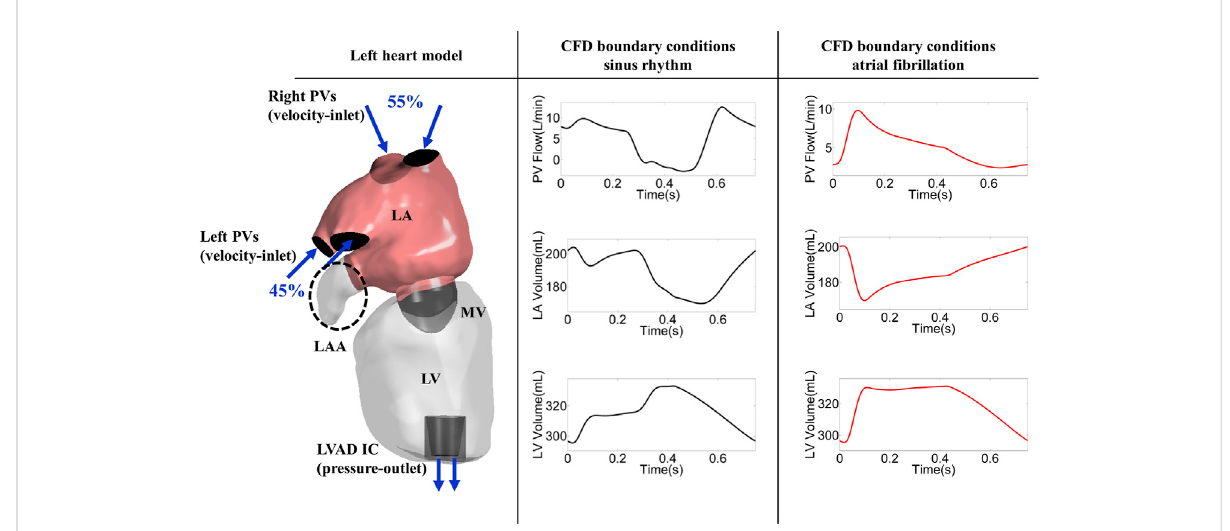
FIGURE 1 Leftheartmodel(encircleddashedellipsemarksLAAO)andCFDboundaryconditions;PV:pulmonaryvein,LA:leftatrium,LV:leftventricle,MV: mitral valve, LAA: left atrial appendage, SR: sinus rhythm, AF: atrial fi brillation, LVAD: left ventricular assist device, IC: in fl ow